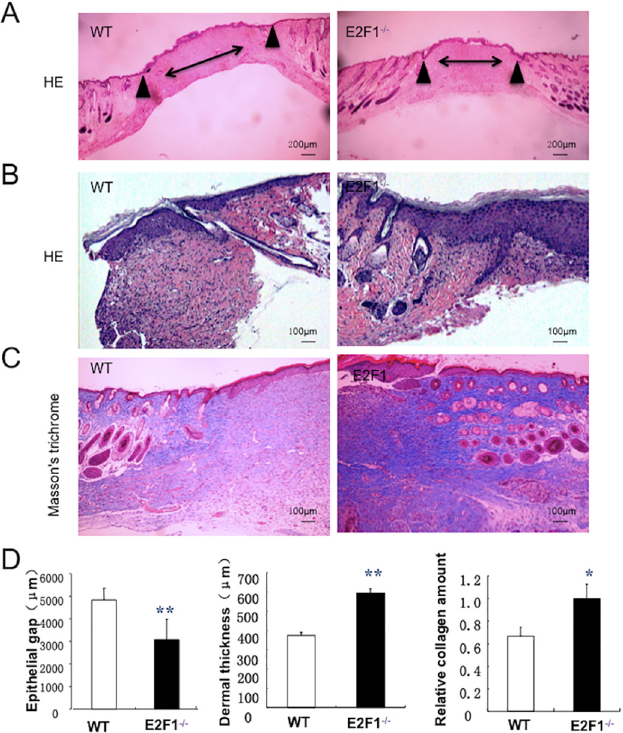
Fig 2. The dermal thickness and collagen amount are greater in E2F1 – / – mice than in WT mice. Wound tissues were isolated at day 7 post-surgery and analyzed histologically. (A-B) H.E. and (C) Masson ’ s trichrome staining. Both entire wound (A) and wound border zone (B-C) are shown. Arrowheads indicate edges of wound granulation tissue. Double-headed arrow bars indicate the distance between the leading edges of wounded epidermis. (D) Quantifications of Epithelial gap ( left panel ), dermal thickness ( middle panel ), and collagen deposition ( right panel ). ** p < 0.01, * p < 0.05; n = 10 per